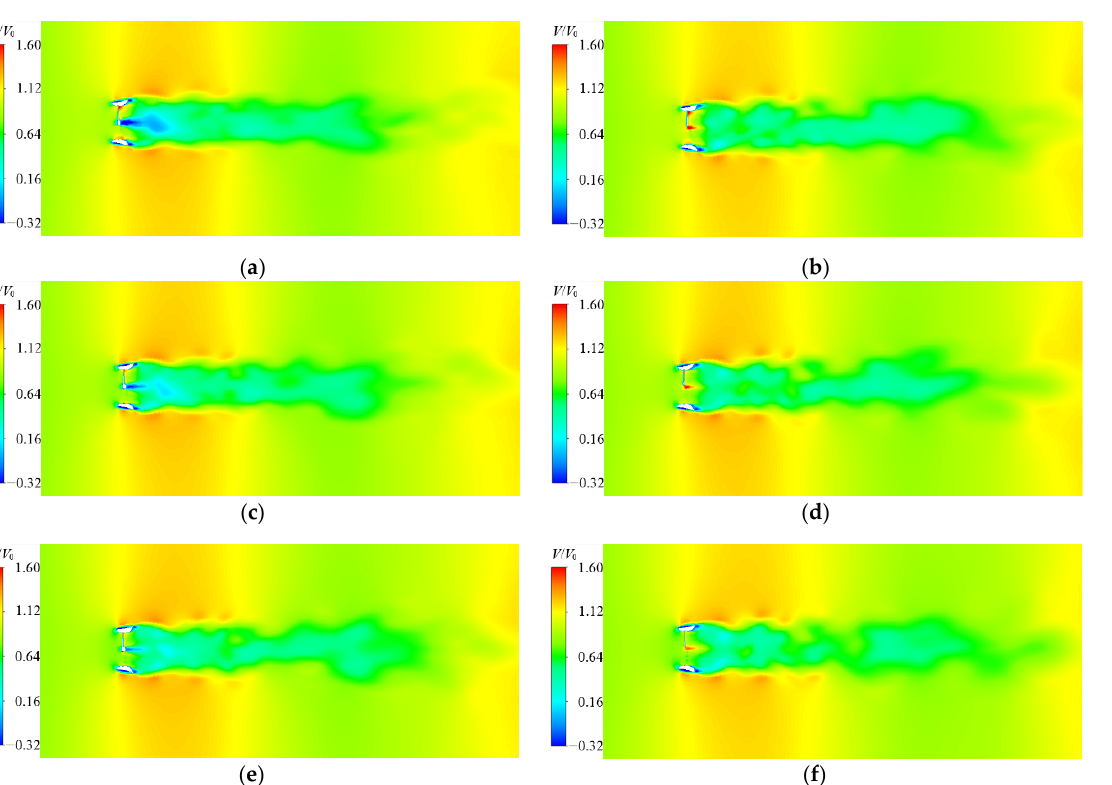
Figure 12. Velocity component contours for the two configurations in the x - y plane of z / D =0.1: ( a ) axial velocity contours; ( b ) tangential velocity contours; ( c ) radial velocity contours.